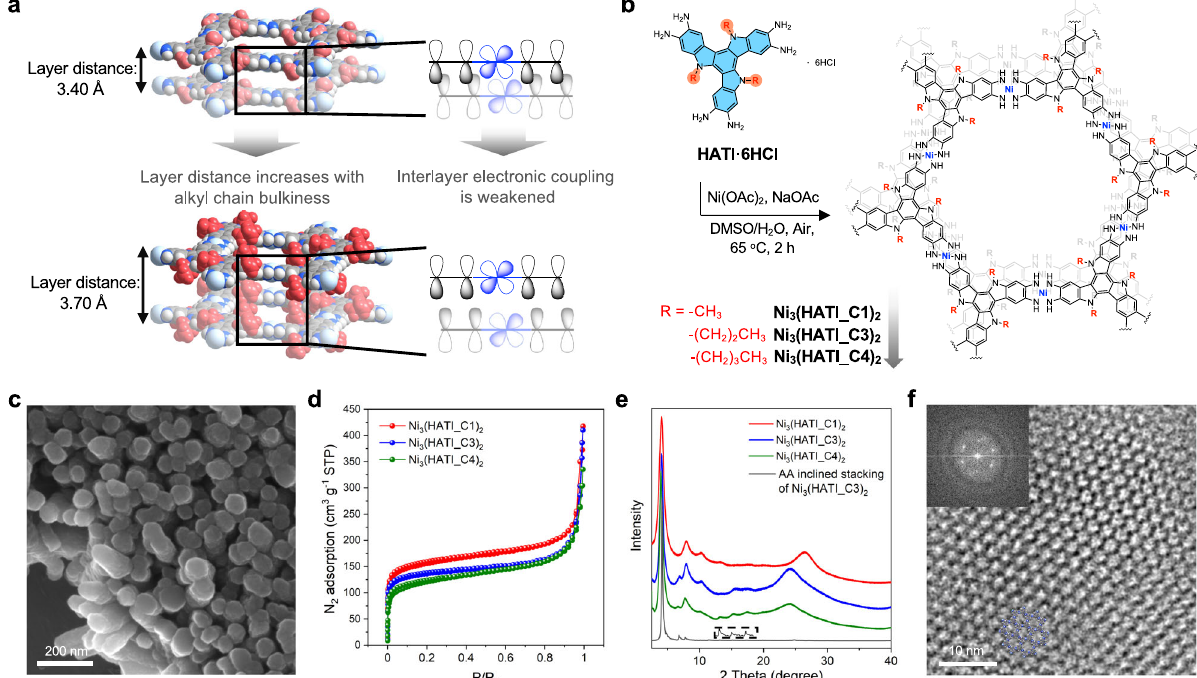
Fig. 1 | Design, synthesis, and structural elucidation of2D c-MOFs. a Schematic diagram of the conceptof the precise controloftheinterlayerelectroniccoupling. red balls: alkyl chains; gray balls: C; white balls: H; blue balls: N; cyan balls: Ni. b